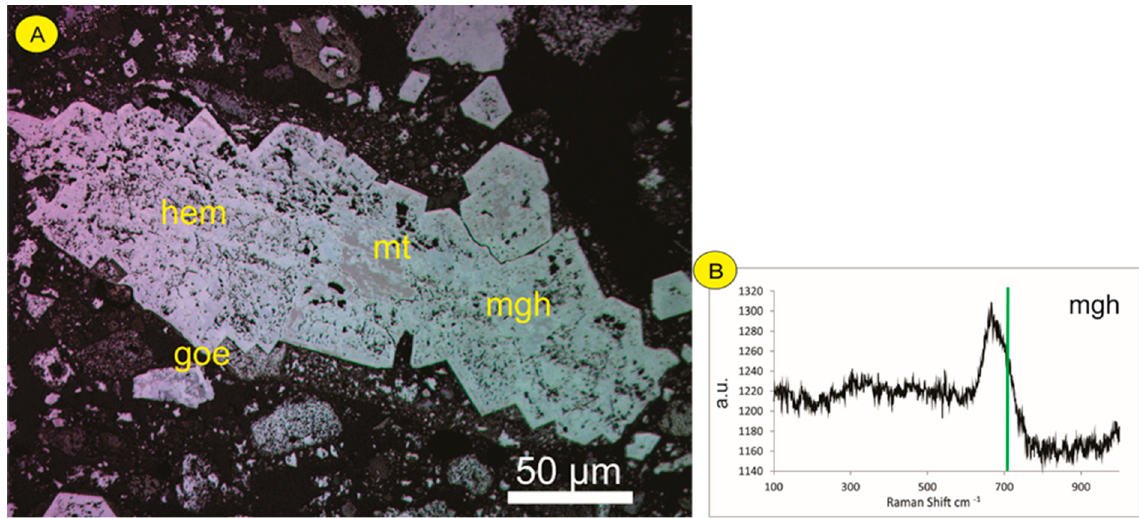
Figure 7. ( A ) Reflected light microscopy bright field image of a N4WS grain with intergrowth of hematite (hem, light gray), maghemite (mgh, bluish gray), magnetite (mt, pinkish gray), and goethite (goe, dark gray); ( B ) Raman spectrum of maghemite with marker at the diagnostic vibration at 720 cm − 1 , measured at the mgh domain in ( A ).